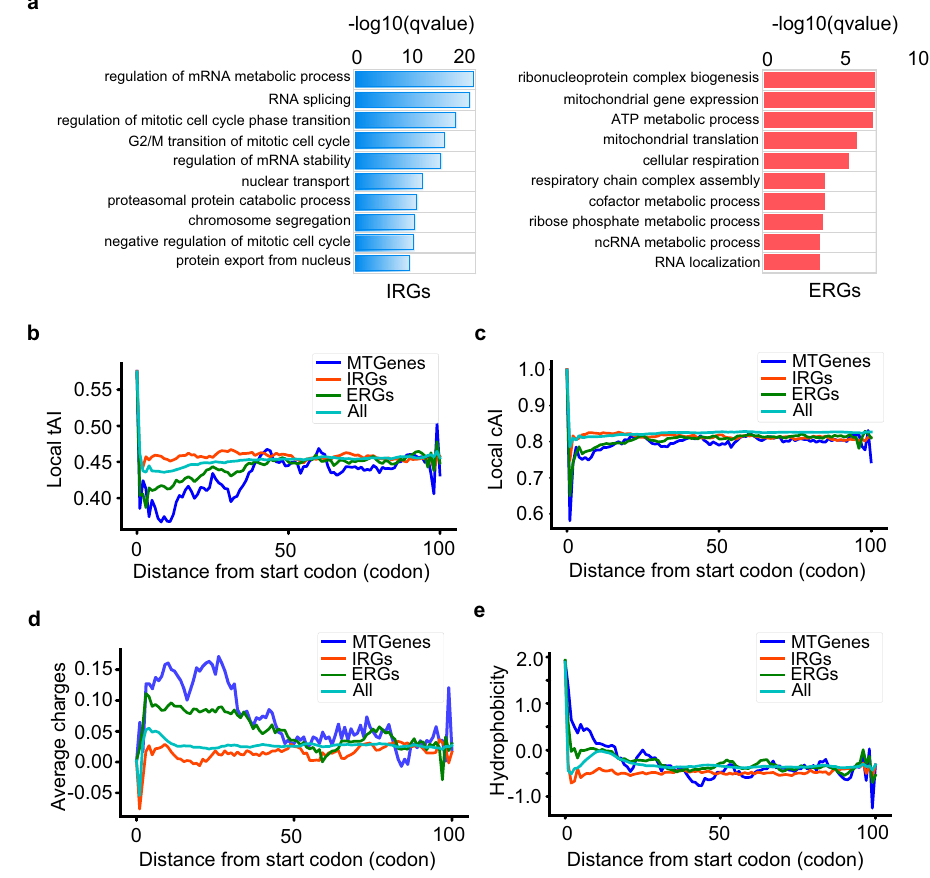
Fig. 3 | Characterizations of ERGs and IRGs. a The results of gene ontology (GO) analyses. b Metagene plots of local tAIfor different gene sets, including a set of all the 19636 transcripts (All), 374 ERGs, 643 IRGs, and 64 mitochondrial function- associated genes (MTGenes). c Metagene plots of local cAI for the different gene